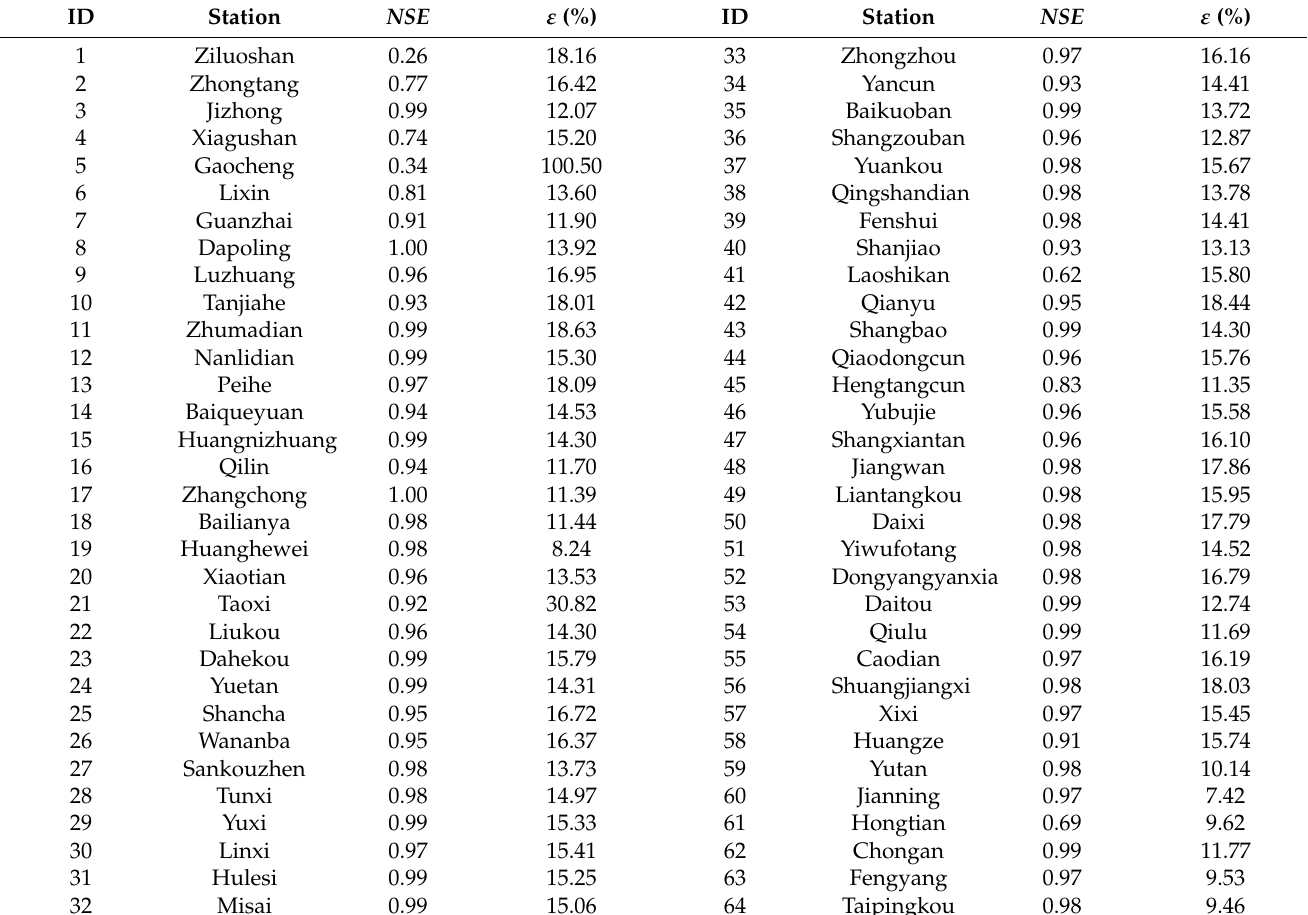
Table A4. The NSE and ε values of simulated FDCs to the observed FDCs for each of the 64